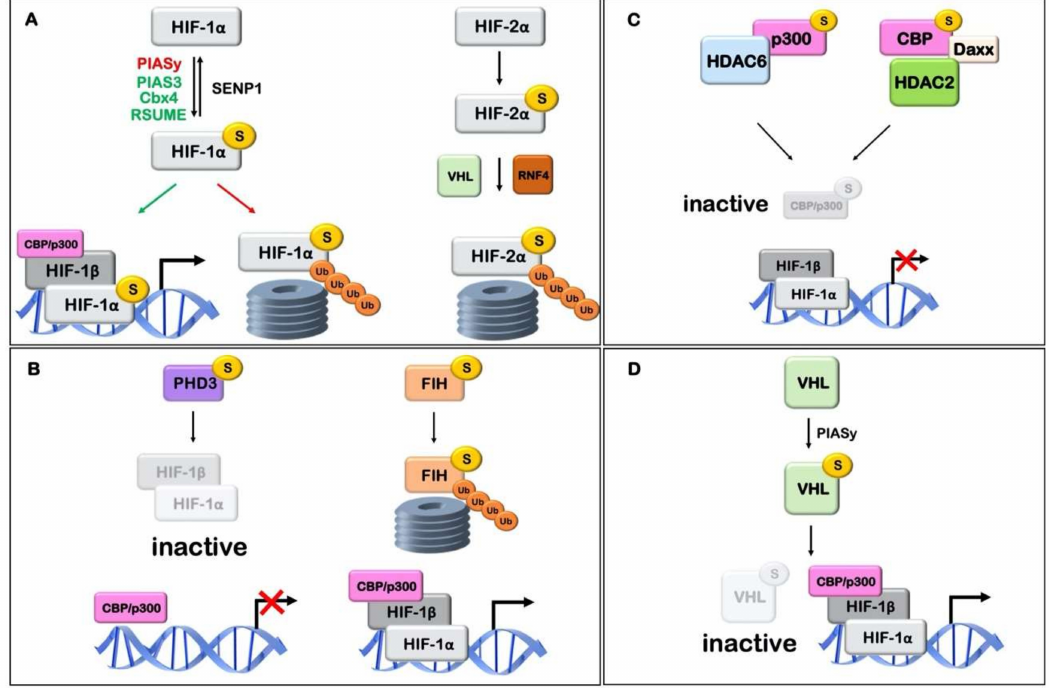
Figure 3. Schematic representation of the association of hypoxic signaling agents with SUMO and its effect on hypoxia inducible factor (HIF) stability and activity. ( A ) HIF α sumoylation affects its transcriptional activity. E3 ligases PIAS3, Cbx4 and RSUME may mediate sumoylation and activation of HIF-1,